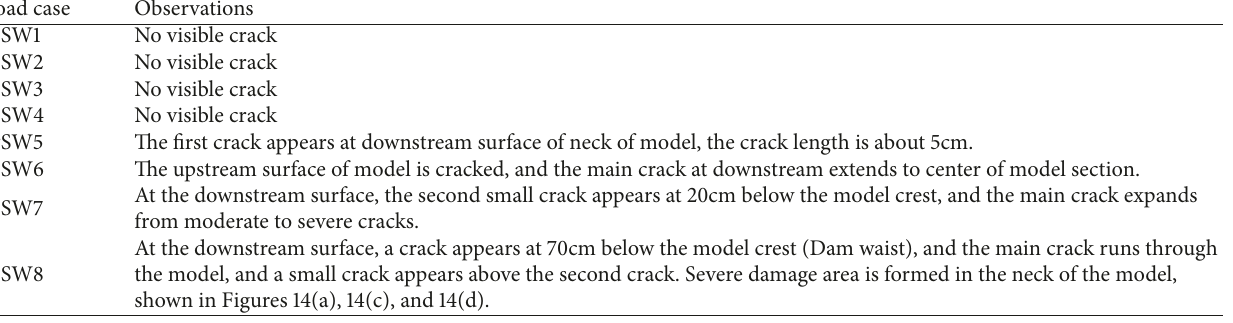
Table 8: Model crack responses during the testing.